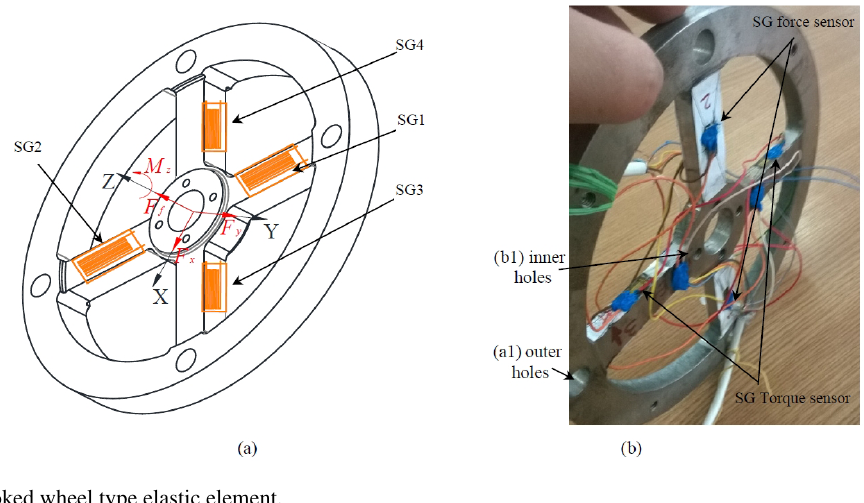
Figure 2. A four-spoked wheel type elastic element.